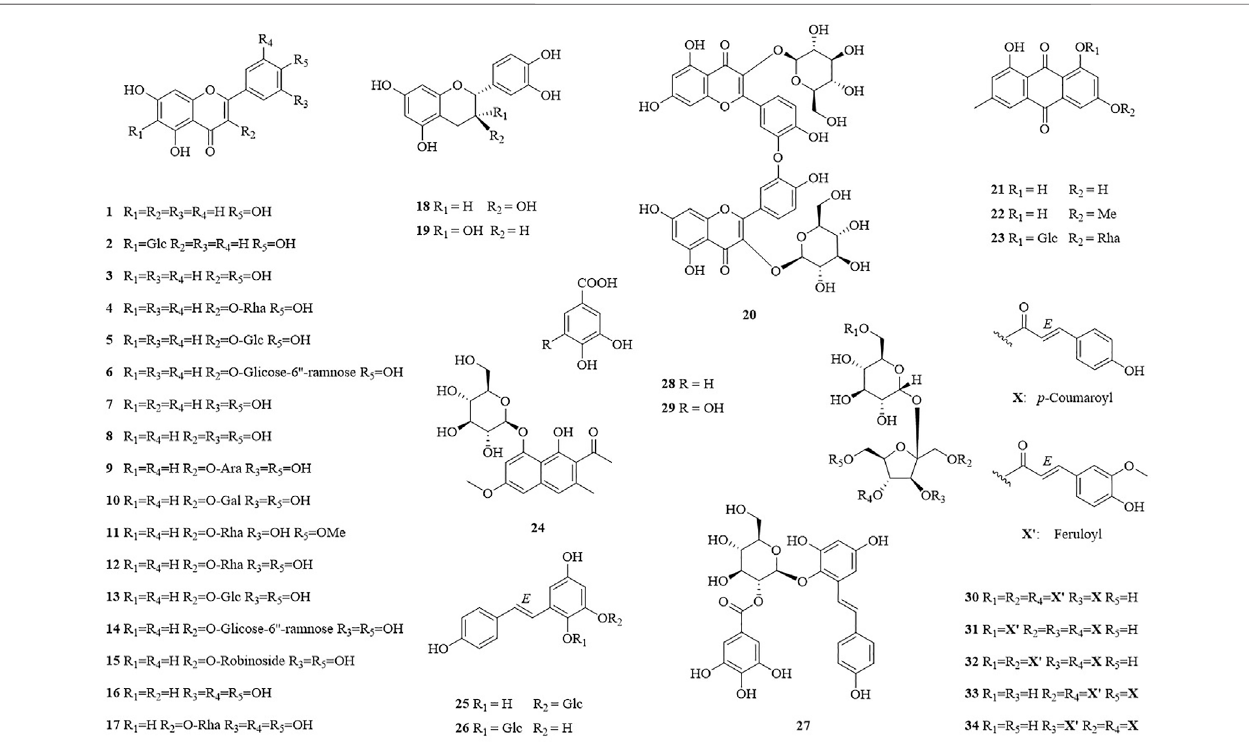
FIGURE 1 | Structure of isolated compounds 1 – 34 from F. dentatoalata